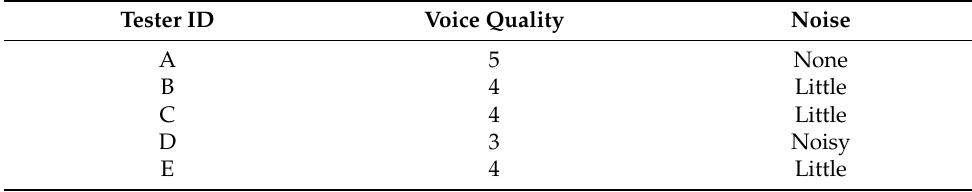
Table 2. Voice call quality